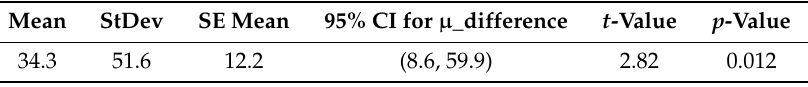
Table 7. Estimation for Paired Difference. 254